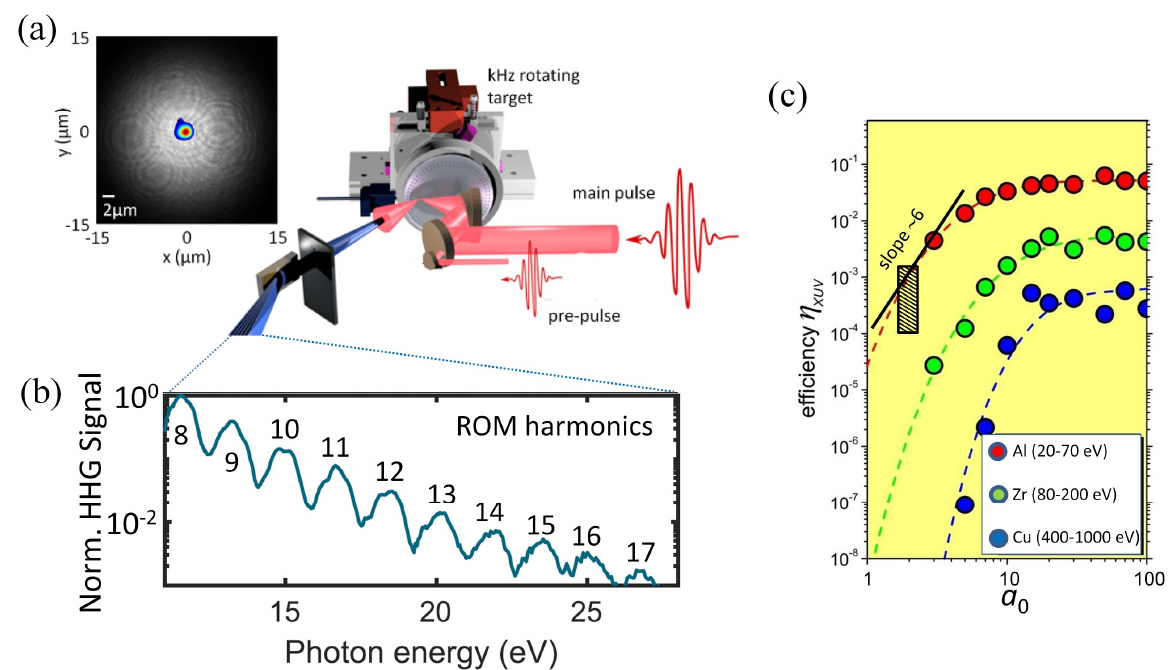
Figure 3. ( a ) A drawing of the 1 kHz repetition rate relativistic high harmonic generation (RHHG) source. A p-polarized ≈ 3.6 fs carrier-envelope-phase (CEP) stablilized IR pulse is focused onto a rotating SiO 2 disc target. The <2- µ m, <100- µ rad target surface stability during the rotation is ensured by precise alignment and high-quality bearings [50], ensuring the intensity stability in each laser shot. The number of available shots on the target is ~10 6 . The plasma expansion is initiated by a pre-pulse arriving on the target a few ps before the main pulse. The spatial profiles of the pre- and main pulses on the target surface are shown on the left panel in gray and color scale, respectively. The spot size of the pre-pulse is much larger than the main pulse in order to ensure a homogenous plasma expansion. Spatial filtering approaches can also be used for optimizing the transmission/detection of the RHH and eliminate any residual part of the XUV radiation generated by any contribution of the coherent wake emission HHG process. ( b ) The spectrum of the generated RHH (generated by a sinusoidal 3.6 fs field) is recorded by an angle-resolved conventional XUV grating spectrometer. ( c ) Calculated conversion efficiency of the HHG process for different values of a 0 and different XUV spectral regions. The square line-shaded area depicts a rough value of the conversion efficiency estimated for the conditions used for the generation of the harmonics shown in ( b ). Using this figure we can roughly estimate, that the non-linearity of the RHH emission with respect to the driving field intensity in the region of a 0 ≈ 2 is ~6 (solid black line). The figures ( a ) and ( b ) are reproduced from ref. [29], and the ( c ) from refs